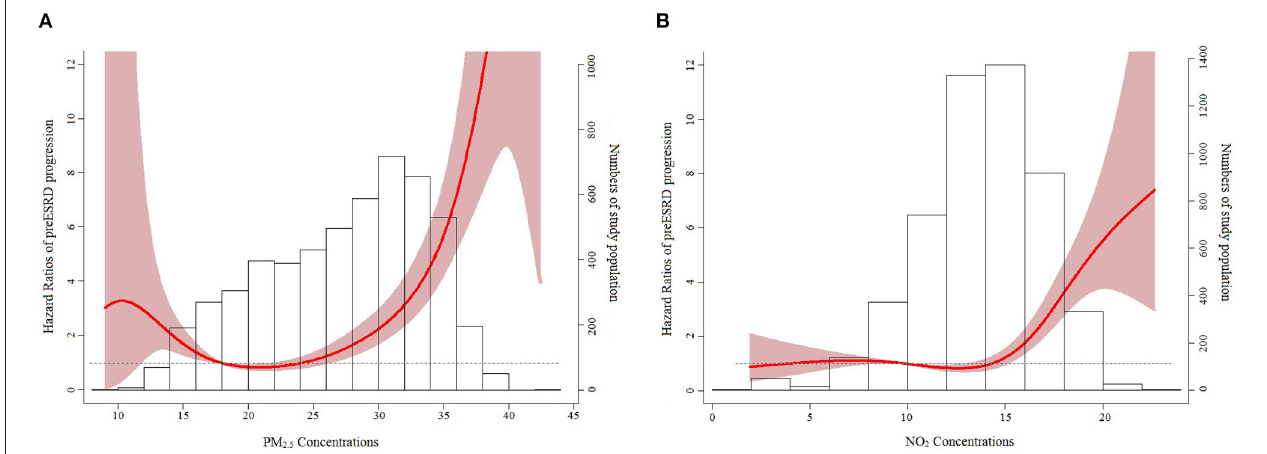
FIGURE 4 | Nonlinear relationships of PM 2.5 ( µ g/m 3 ) (A) and NO 2 (ppb) (B) with eGFR